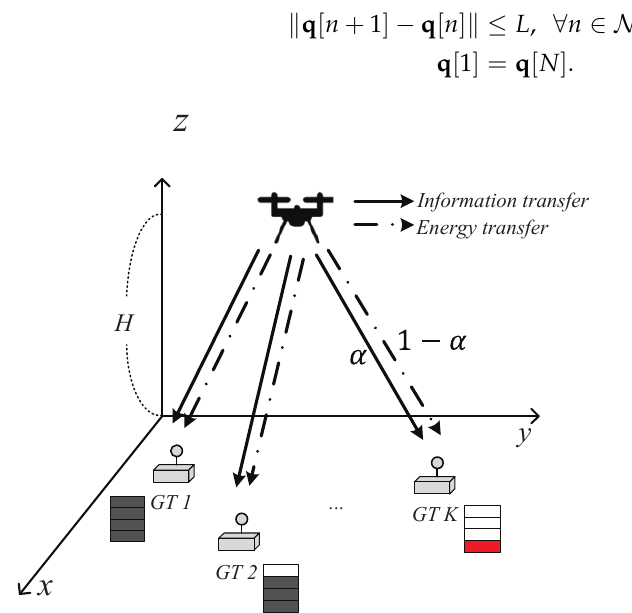
Figure 1. Systme model of a UAV-aided downlink SWIPT. Figure 1. System model of a UAV-aided downlink